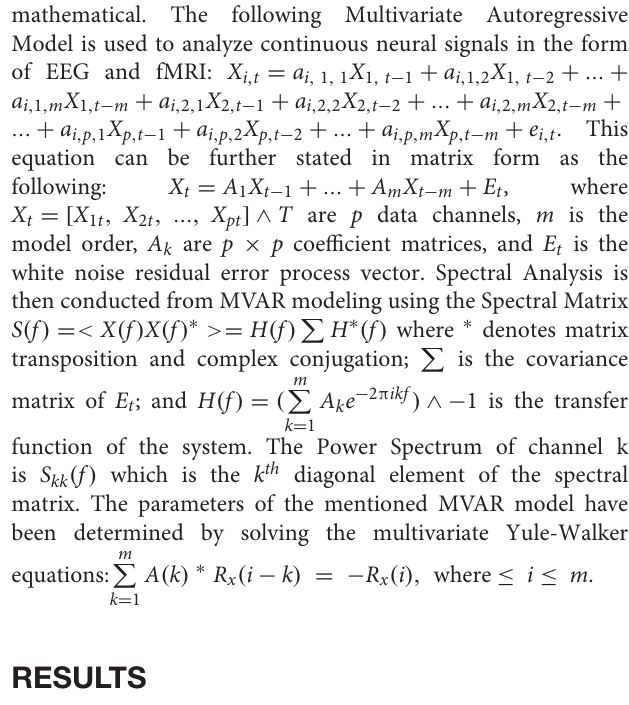
Coherence spectra displayed synchronization of